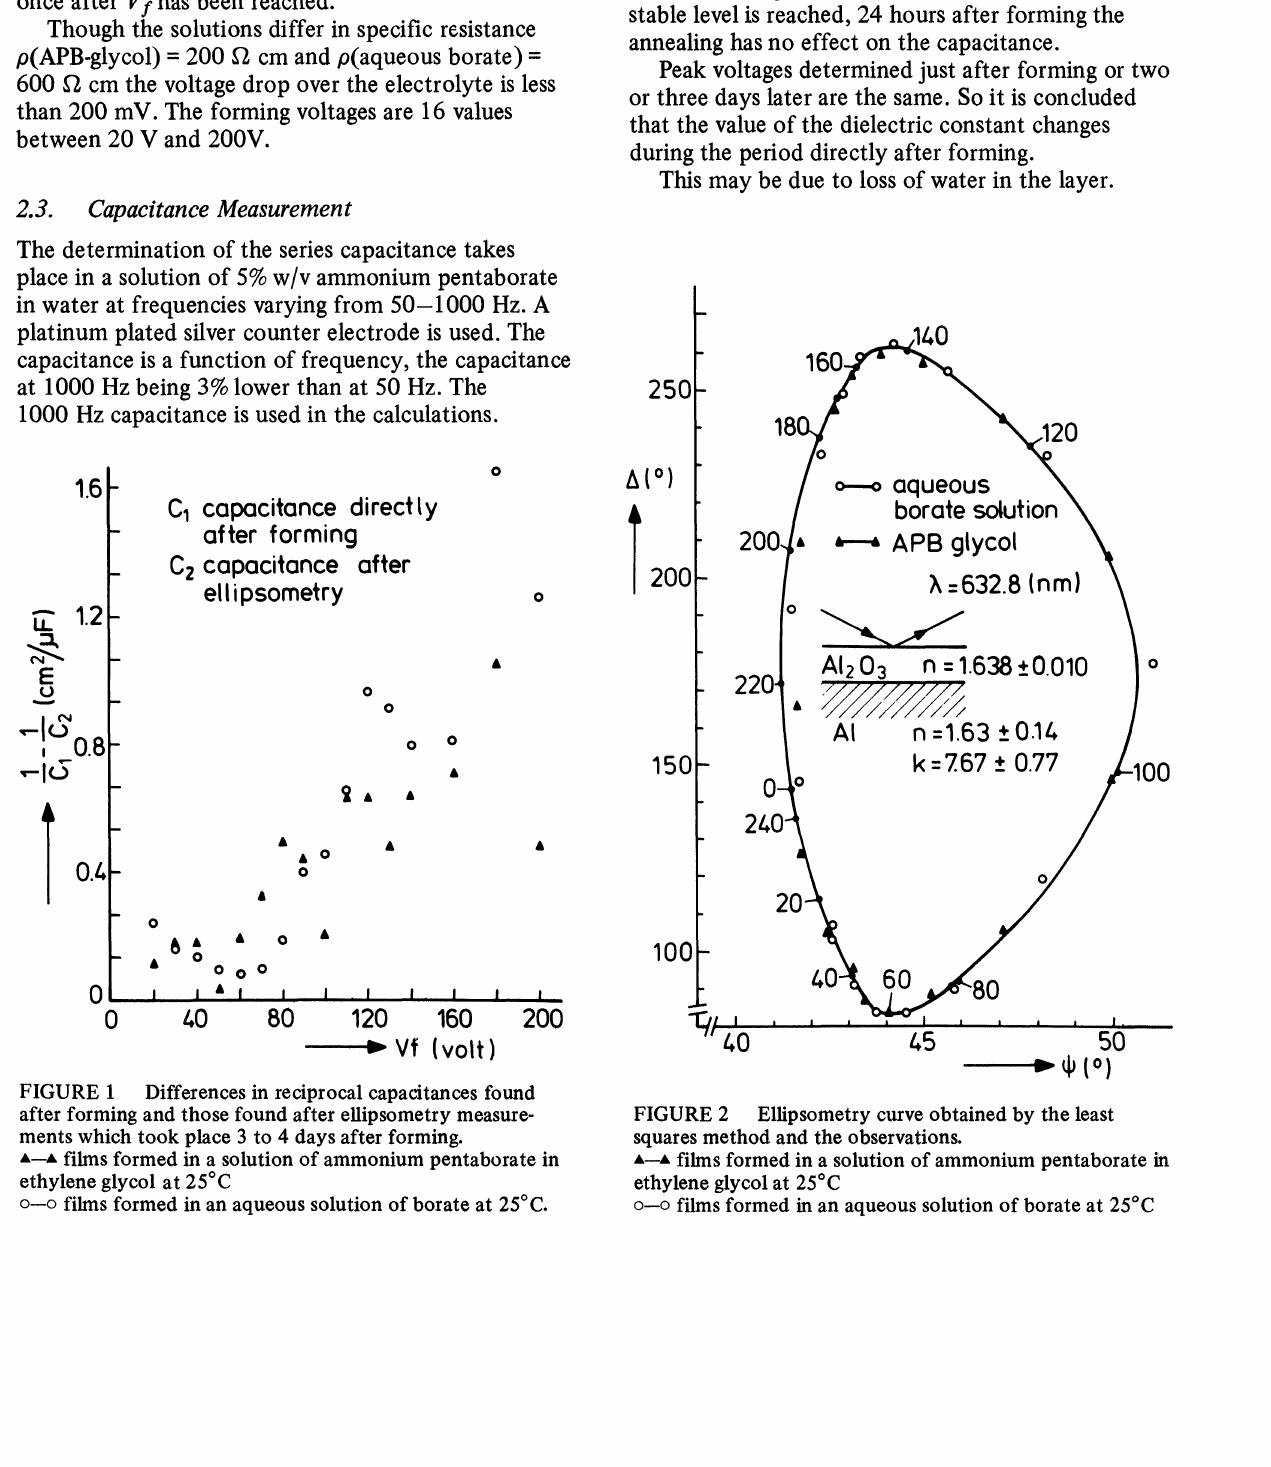
Differences in reciprocal capacitances found after forming and those found after ellipsometry measure- ments which took place 3 to 4 days after forming. A--A films formed in a solution of ammonium pentaborate in ethylene glycol at 25C o--o films formed in an aqueous solution of borate at 25 C.